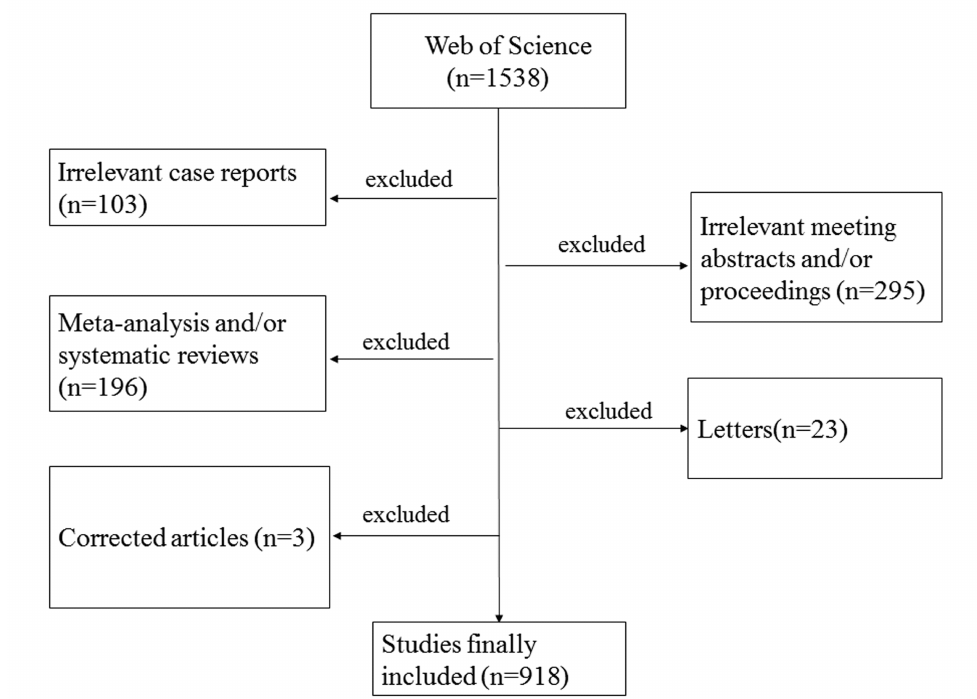
Fig. 1. Flow diagram of the included papers.